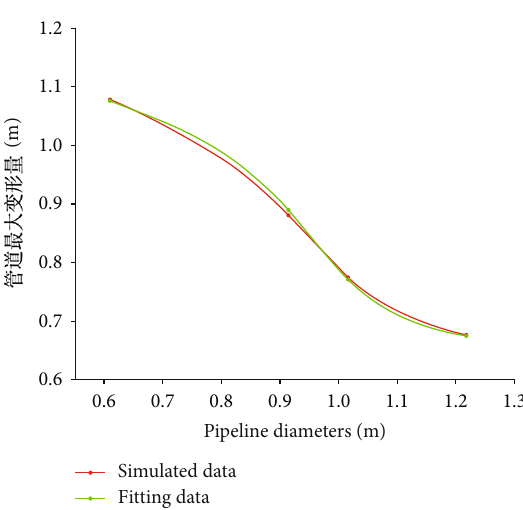
Figure 23: The pipeline maximum displacement under di ff erent pipeline diameters.